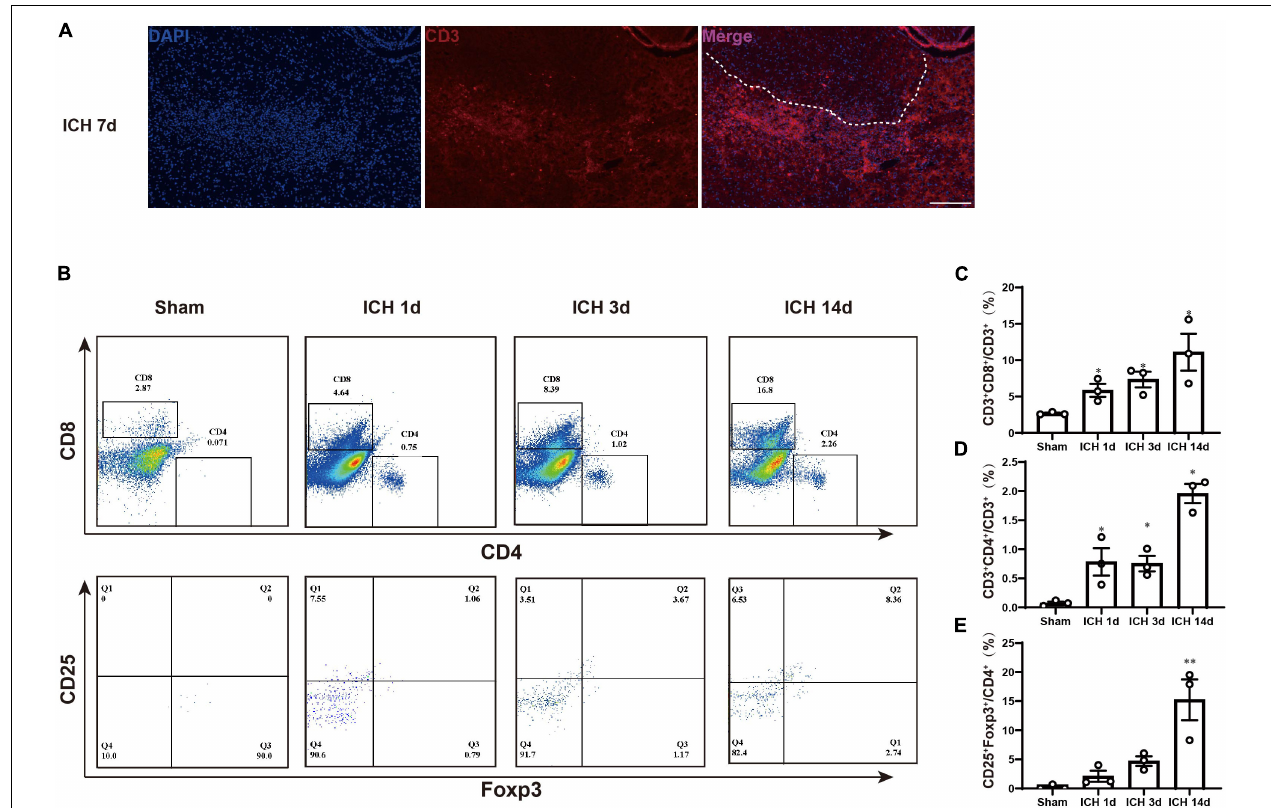
FIGURE 3 | T cell accumulation in the brain after ICH. (A) Immunofluorescence staining for CD3 in the hemorrhagic brain on 7 days after ICH. White dotted line indicates the hemorrhagic region. Scare bar = 200 µ m. (B–E) Flow cytometric analysis of T cells in the hemorrhagic brain on 1, 3, and 14 days after ICH ( n = 3 per group). Data are expressed as the mean ± SEM. ∗ P < 0.05. ∗∗ P < 0.01. P < 0.001 vs . sham